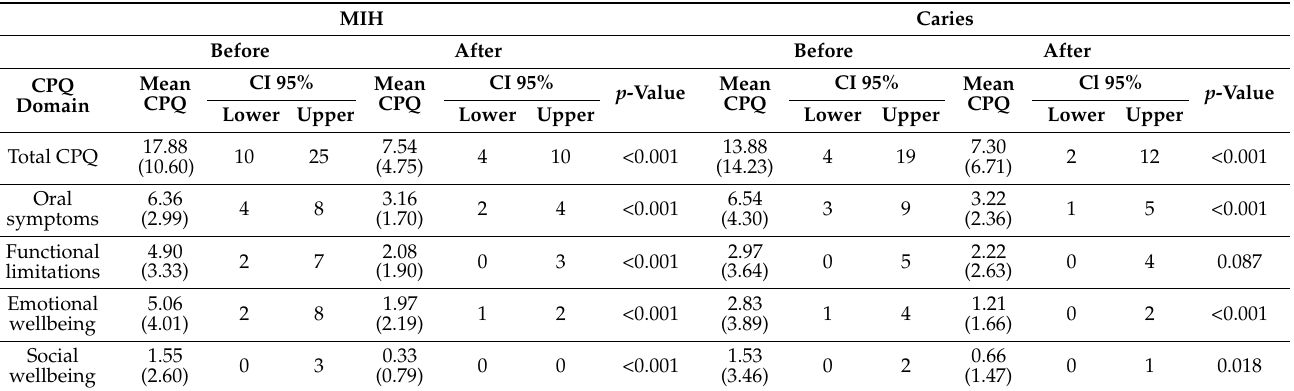
Table A2. Means and Confidence Intervals for CPQ Subscale Scores for the MIH and Caries Group Before and After Therapy.